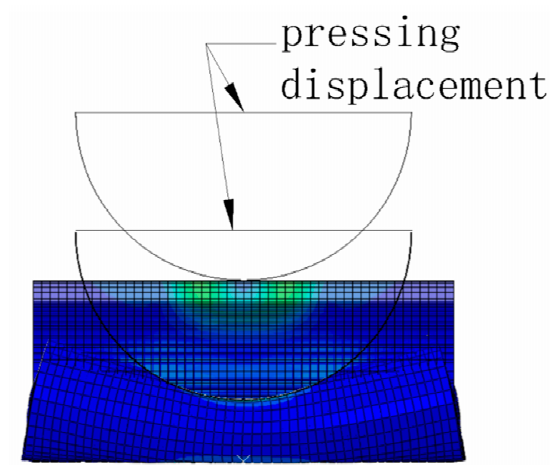
Figure 6. Pressing Figure 6. Pressing displacement.